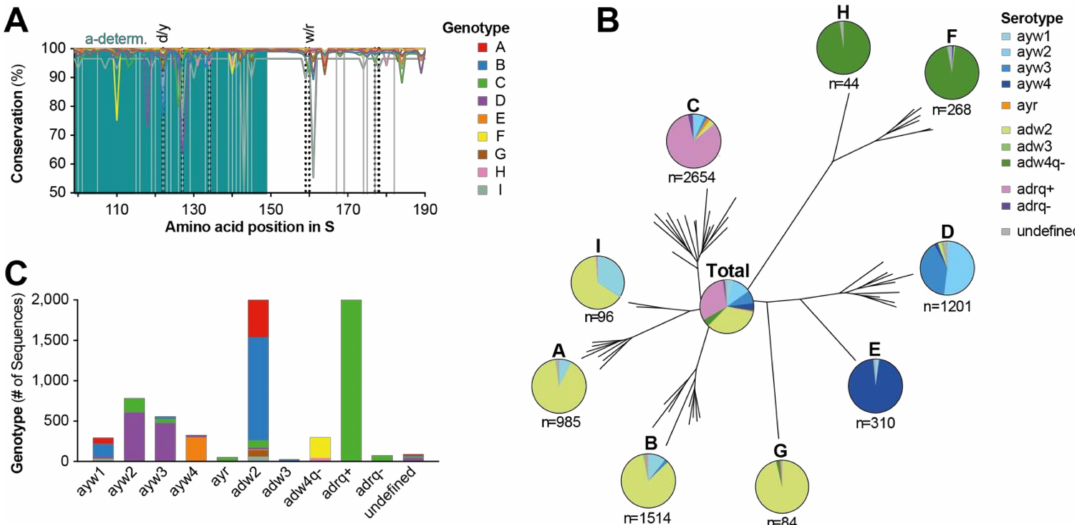
Figure 2. Distribution of HBV serotypes. ( A ) Amino acid conservation of HBsAg (starting at position 99 of S, marking the beginning of the major hydrophilic region) for each HBV genotype was determined by using the consensus sequence of each genotype as a reference. Relevant positions for serotype prediction are indicated by vertical dotted lines. Positions at which clinically relevant mutations occur (for details see Figure 3) are indicated by vertical gray lines. a-determ. = a-determinant. ( B ) Distribution of predicted serotypes within each HBV genotype. The serotype distribution of all global HBV sequences is shown in the middle. The phylogenetic tree was obtained using reference sequences for all HBV genotypes and sub-genotypes, which were employed to identify genotypes of sequences by Basic Local Alignment Search Tool (BLAST) search (see methods for details). ( C ) Total number of sequences with a certain serotype, subdivided by their